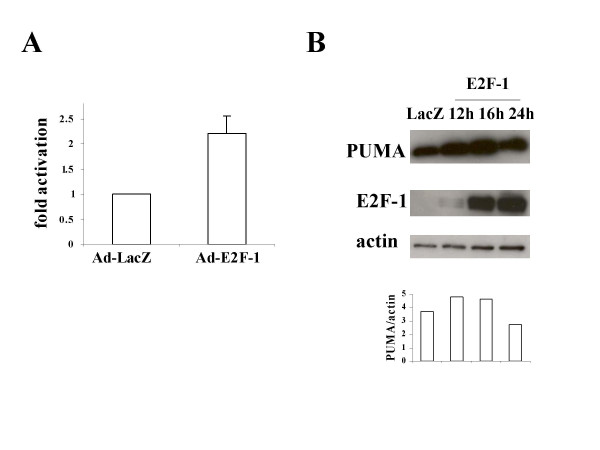
A. E2F-1 expression up-regulates the activity of the PUMA promoter in HCT116 PUMA+/+ cells. HCT116 PUMA+/+ cells were co-transfected with a total of 0.82 μg of DNA, including 0.8 μg of PUMA promoter reporter plasmid and 0.02 μg phRL-CMV plasmid (as an internal control) in a 12-well plate by using Lipofectamine 2000 transfection reagent, and then processed as in Fig. 2A. 4B Up-regulation of PUMA at the protein level after Ad-E2F-1 expression in HCT116 PUMA+/+ cells. Western blot analysis of PUMA was performed in HCT116 PUMA+/+ cells at indicated time points as in Fig. 1B. PUMA/actin showed the ratio of the scanned optical density of each protein band. PUMA protein level was increased at 12 hours and 16 hours of infection with Ad-E2F-1.